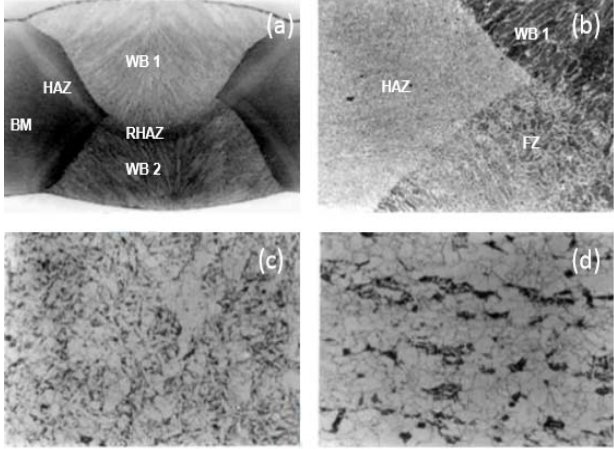
Figure 3. Microstructures of API X65 micro ‐ alloyed steel weldment: ( a ) Weldment zones; ( b ) Microstructure showing the FZ, HAZ and WB 1; ( c ) interface between HAZ and WB; and ( d ) Base Metal (BM), ferrite (light areas) and pearlite (dark areas).